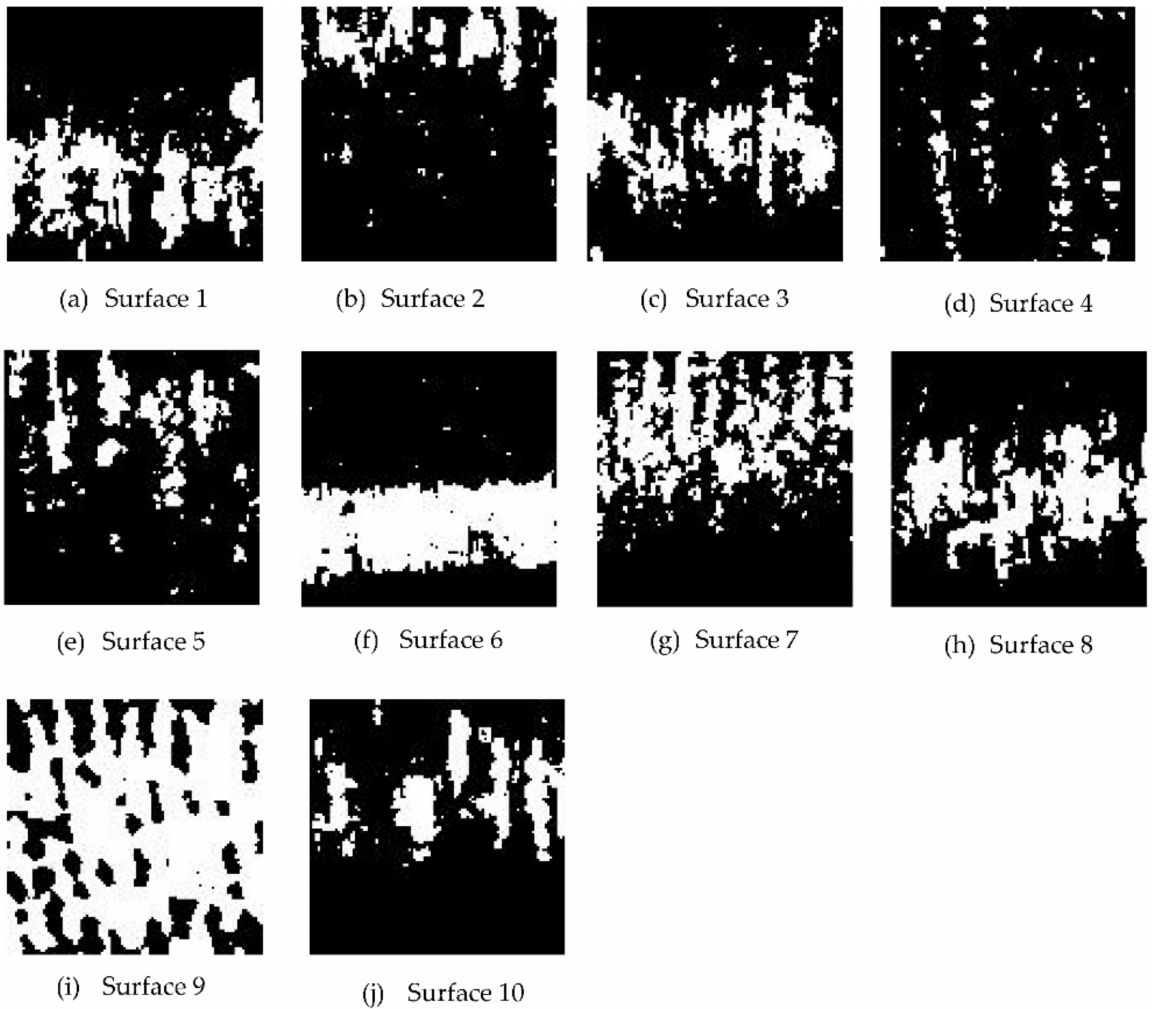
Figure 7. ( a – j ) are the binary images of the laser speckle pattern images for each surface at illumination angle of 45 ◦ , f number of 16 and shutter speed of 1/100